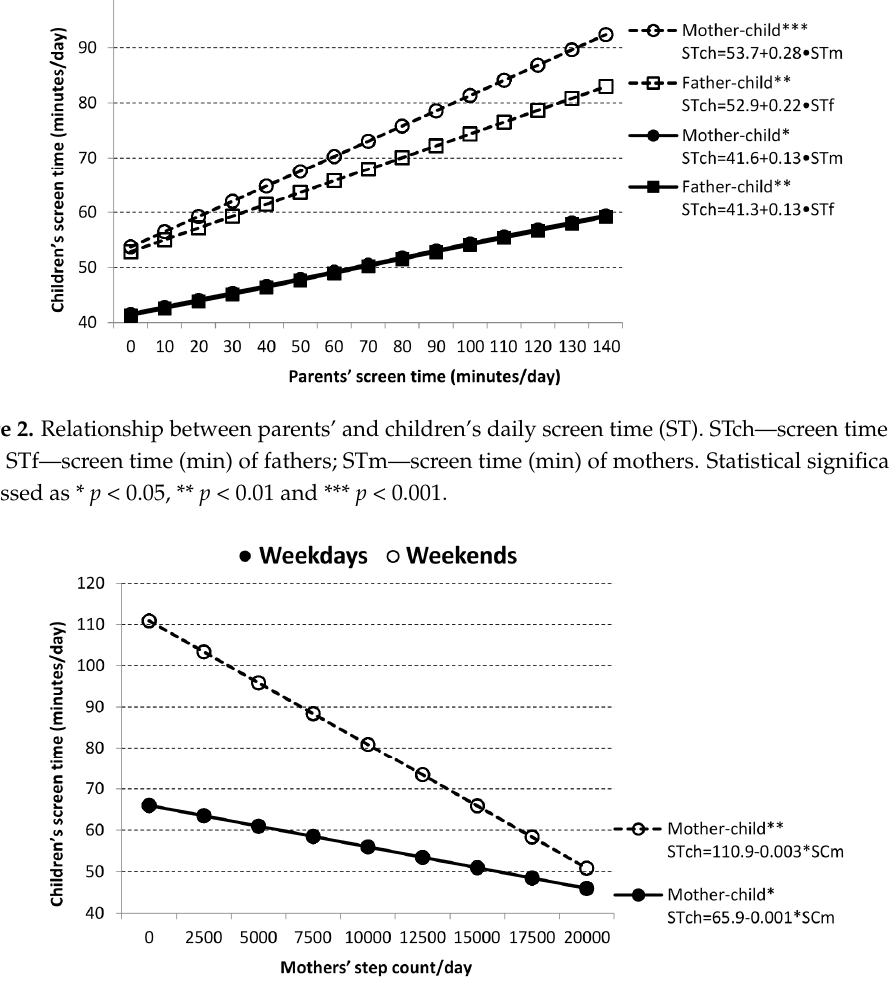
Figure 3. Relationship between children’s daily step count (SC) and mothers’ weekdays ( ● ) and weekends ( ○ ) daily screen time (ST). Statistical significance is expressed as * p < 0.05 and ** p < 0.01.